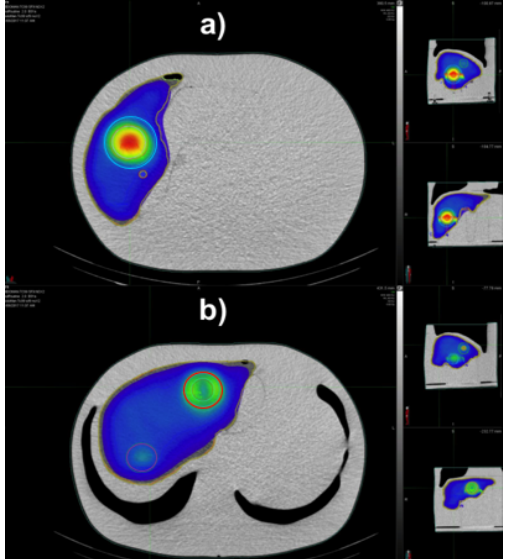
Figure 3. 3D dose distribution for the AbdoMan phantom visualized with MIM color wash tool for the liver section and the 40 mm spheres ( a ), the 20 mm and 40 mm hollow sphere with 25 mm insert ( b ).